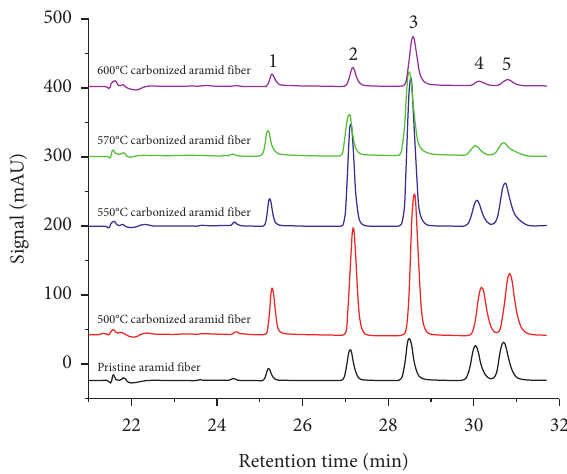
Figure 6: Chromatograms of aramid fiber and aramid fiber carbonized at different temperatures. Peaks: (1) bisphenol A, (2) ethyny- lestradiol, (3) diethylstilbestrol, (4) hexestrol, and (5) estrone. Conditions: sampling volume, 50mL; sampling rate, 2.00 mL/min; and desorption time, 2.0 min. Mobile phase: water/acetonitrile (53 :47, v/v); detection wavelength, 202nm; and room temperature. Table 1: Comparison of enrichment capacity of aramid fiber and aramid fibers carbonized at different temperatures.